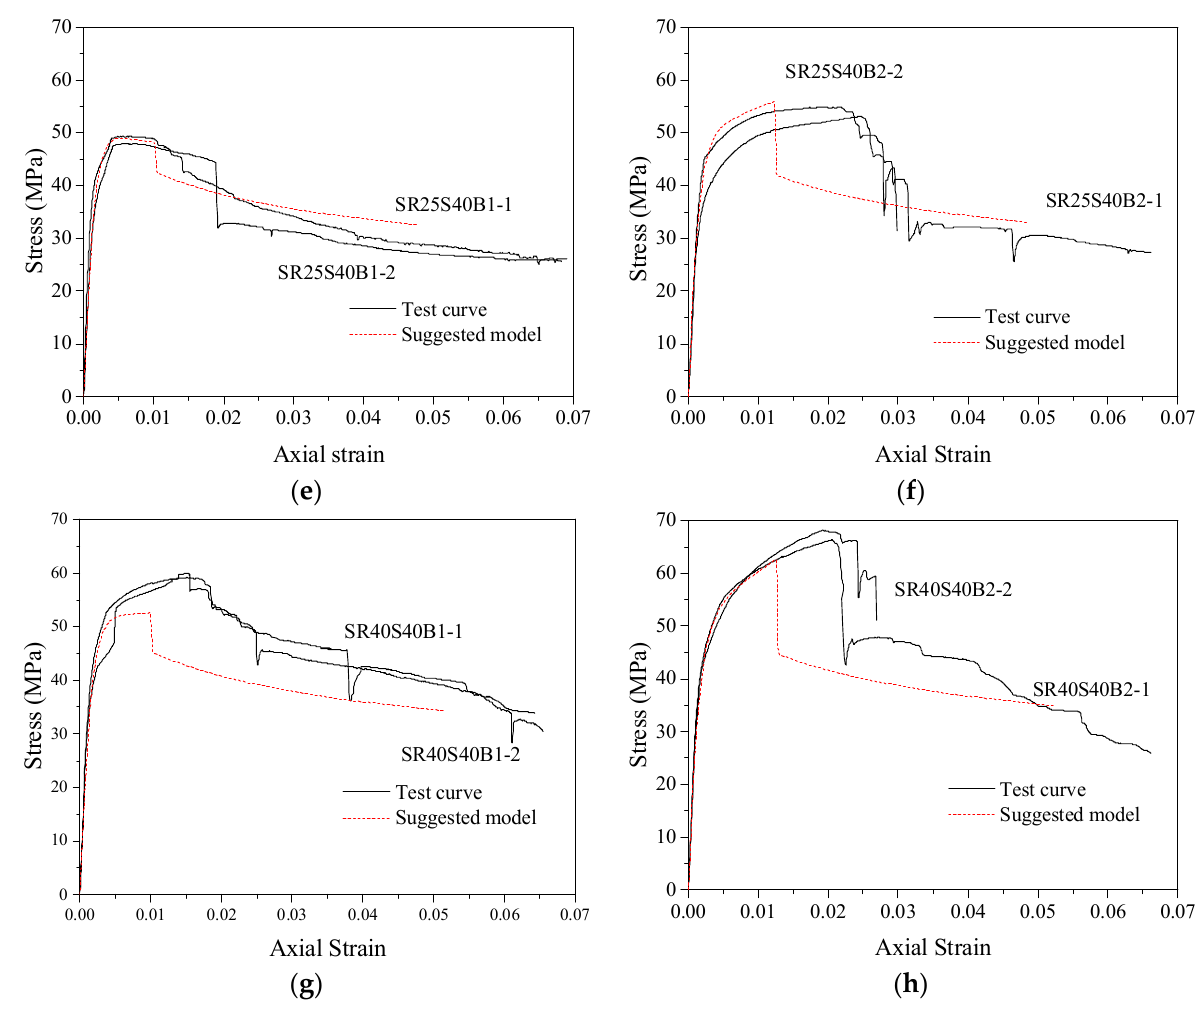
Figure 16. Performance of the stress–strain relationship curve model of FRP–stirrup composite-confined concrete: ( a ) SR5S20B1; ( b ) SR25S20B; ( c ) SR25S20B2; ( d ) SR40S20B2; ( e ) SR25S40B1; ( f ) SR25S40B; ( g ) SR40S40B1; ( h ) SR40S40B2.